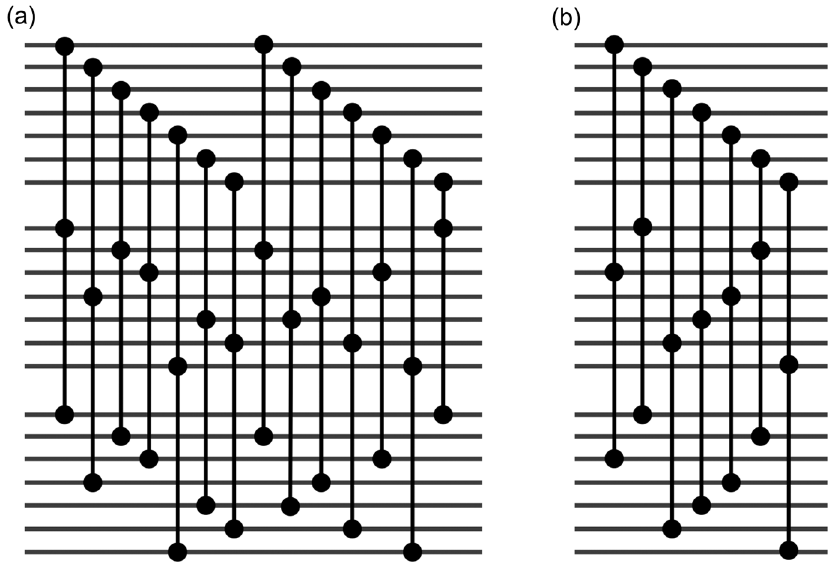
FIG. 7. A pieceable circuit for logical CCZ on the 7-qubit code that uses just 21 physical CCZ gates and two pieces (a), (b). Intermediate error correction consists of Steane syndrome measurement of the Z stabilizers on each block. The final error correction is full Steane syndrome measurement on all blocks. We assume that recovery need not be applied directly. Instead, X errors detected intermediately can be dealt with by adaptively changing the following CCZ gates to be j 0 i controlled on the affected qubits. The first piece has volume 2 × 21 ¼ 42 and the second just 21. Using the circuit volumes of the measurement circuits in Fig. 10, we find the total volume of the pieceable CCZ to be 3 × 21 þ 3 × 81 þ 3 × 155 ¼ 771